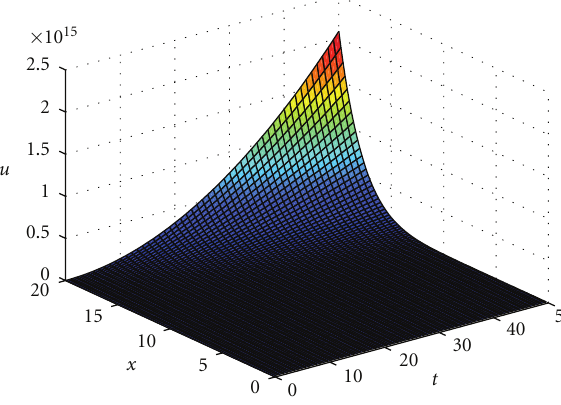
Figure 6: HAM solution with β (cid:8)